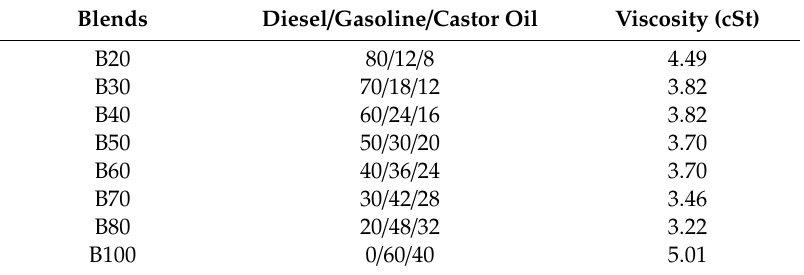
Table 4. Viscosity values of the triple blends, diesel / gasoline / castor oil, obtained by adding di ff erent amounts of fossil diesel to a double mixture of gasoline / castor oil, containing 60%